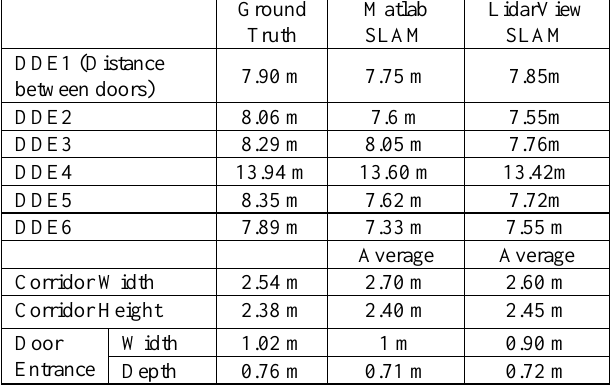
Table 4. Comparison of the localization error for different key